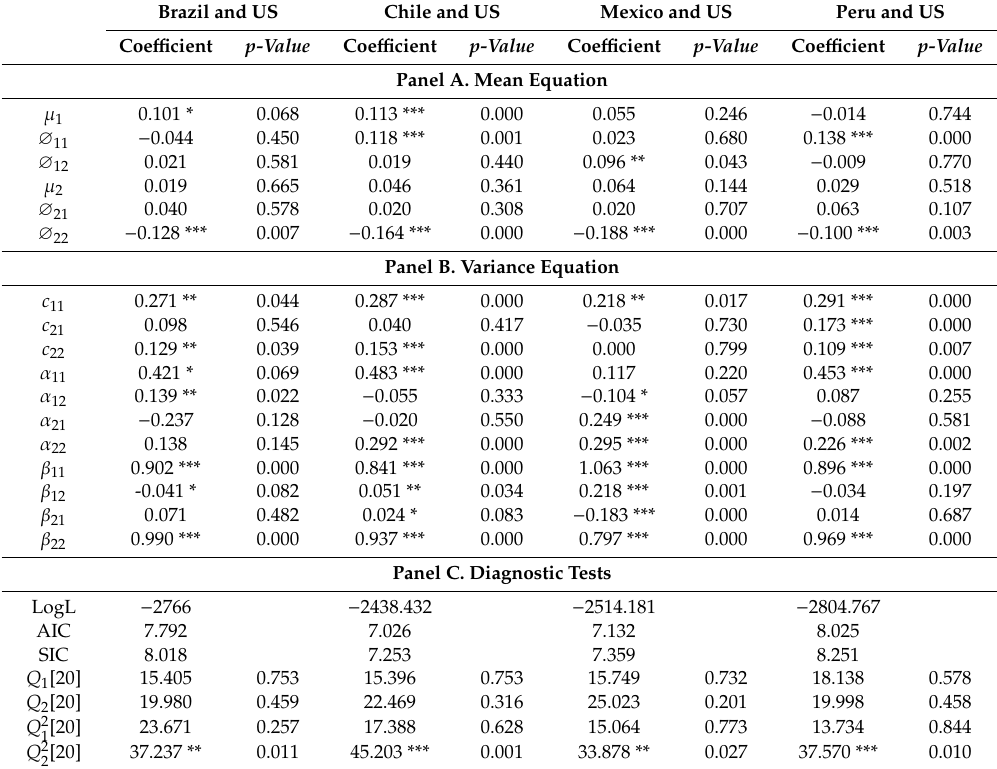
Table 4. Estimates of BEKK-GARCH for US and Latin American stock markets during the global financial